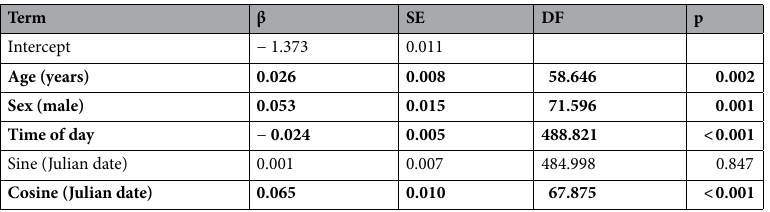
Table 1. Predictors of urinary neopterin levels in 502 samples from 70 sexually mature chimpanzees (N males = 34, N females = 36). SE standard error, DF degrees of freedom estimated by Satterthwaite approximation. Bold font denotes significance. Please note that urinary neopterin levels were Box–Cox transformed prior to analysis.